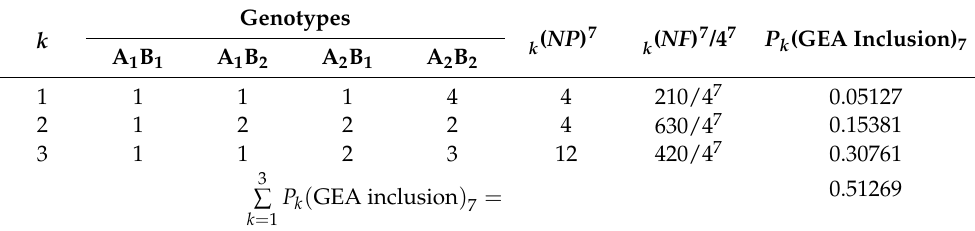
Table 4. Probability that with m = 7. a sample would include all four GEA genotypes (Equation (1)).